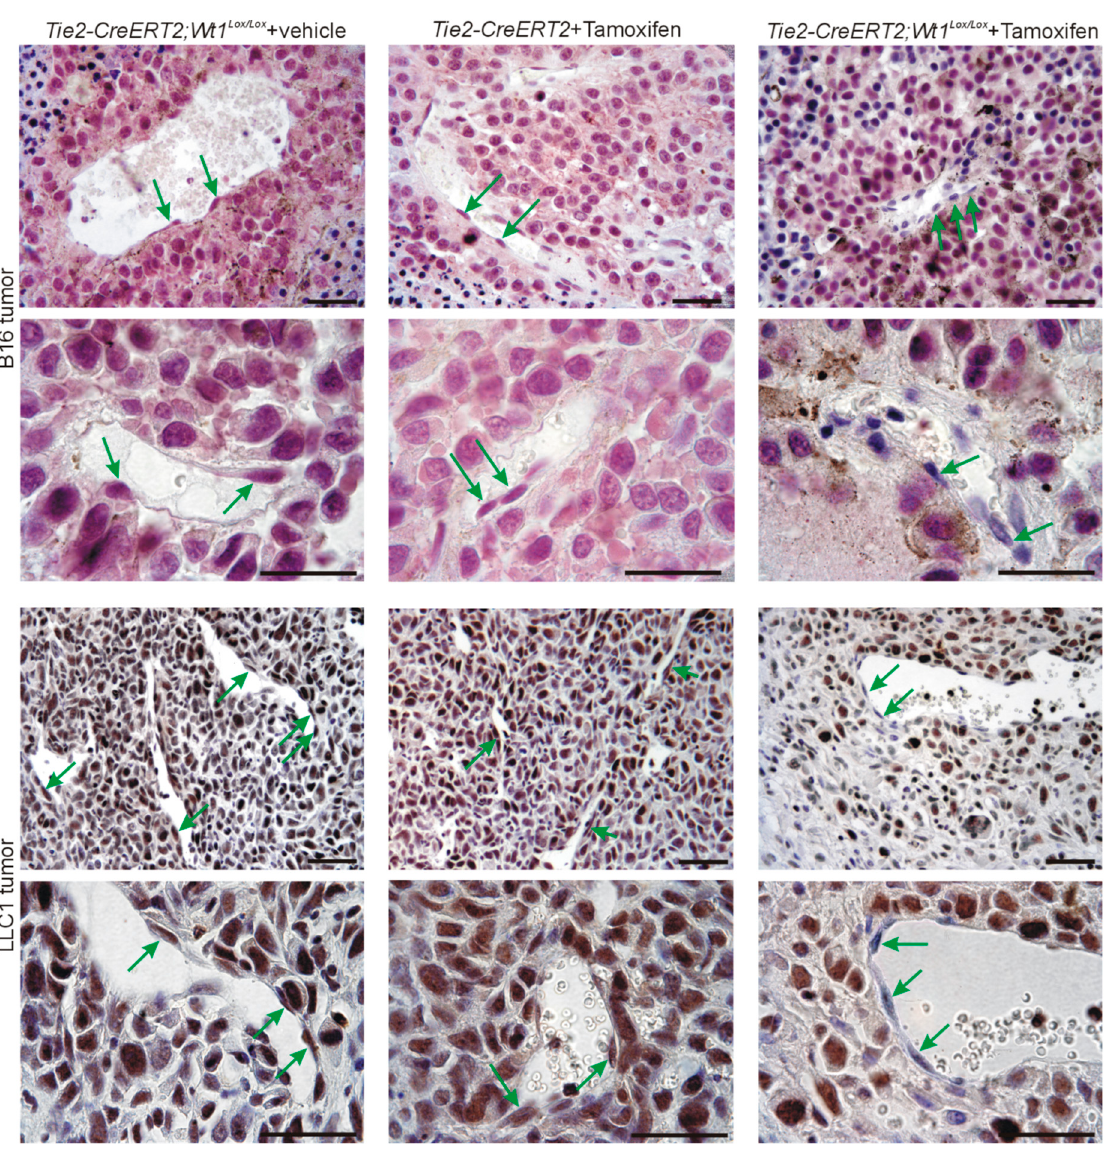
Figure 3. Srsf1 expression in different mouse tumor types. B16 melanoma tumors ( top ) were produced by subcutaneous injection of tumor cells in Tie2-CreERT2 ; Wt1 Lox/Lox mice treated with vehicle ( n = 13) or Tie2-CreERT2 animals ( n = 11) treated with Tamoxifen as controls and in Tie2-CreERT2 ; Wt1 Lox/Lox mice treated with Tamoxifen to knockout Wt1 ( n = 20). LLC1 lung cancer cell tumors ( bottom ) were produced by subcutaneous injection of tumor cells in Tie2-CreERT2 ; Wt1 Lox/Lox mice treated with vehicle ( n = 9) or Tie2-CreERT2 animals ( n = 8) treated with Tamoxifen as controls and in Tie2-CreERT2 ; Wt1 Lox/Lox mice treated with Tamoxifen to knockout Wt1 ( n = 11). Srsf1 immunostaining was visualized with VIP (purple) for melanoma tumors and DAB (brown) for LLC1 tumors. Nuclei were counterstained with hematoxylin (blue). Note the high expression and nuclear localization of Srsf1 in tumor and endothelial cells in Tie2-CreERT2 ; Wt1 Lox/Lox mice treated with vehicle and Tie2-CreERT2 animals treated with Tamoxifen and the absence of Srsf1 in endothelial cells of Tie2-CreERT2 ; Wt1 Lox/Lox animals treated with Tamoxifen. Green arrows point to endothelial cells. Scale bars indicate 50 µm.